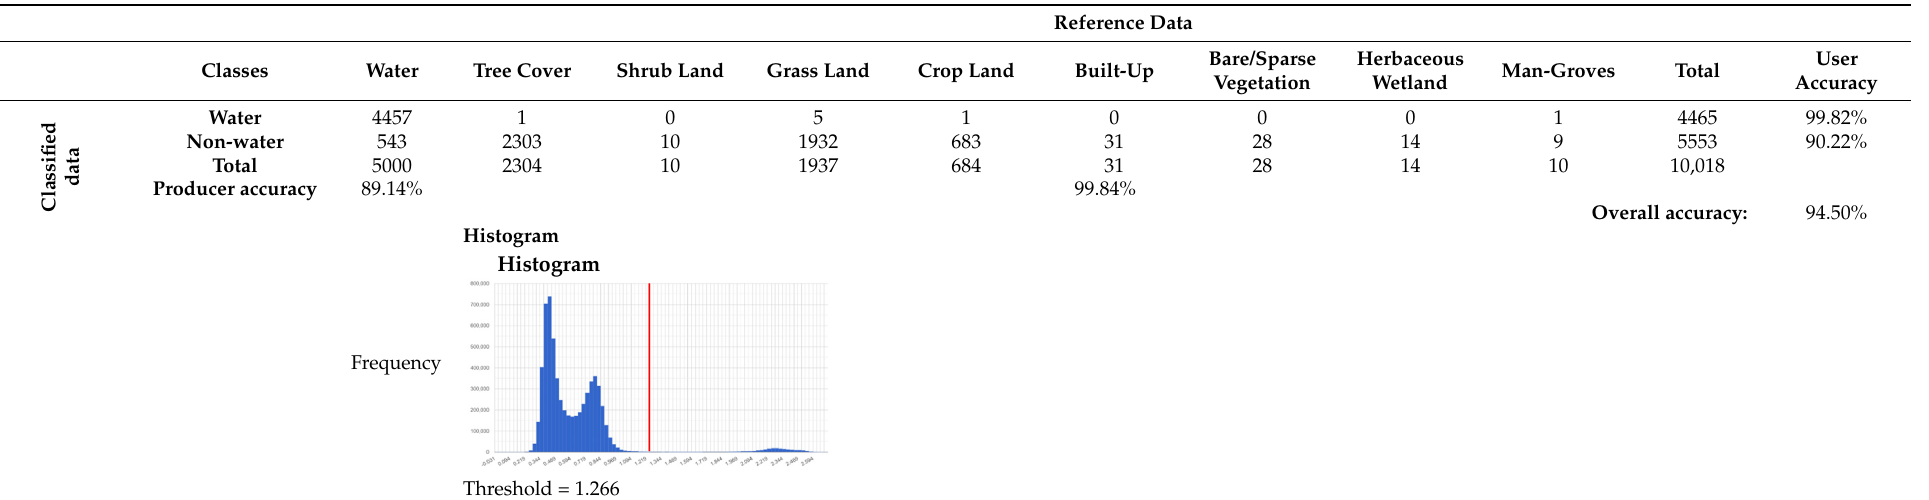
Table 9. Accuracy assessment results for CAWI with a slope mask on Sentinel-2 imagery using Otsu thresholding.